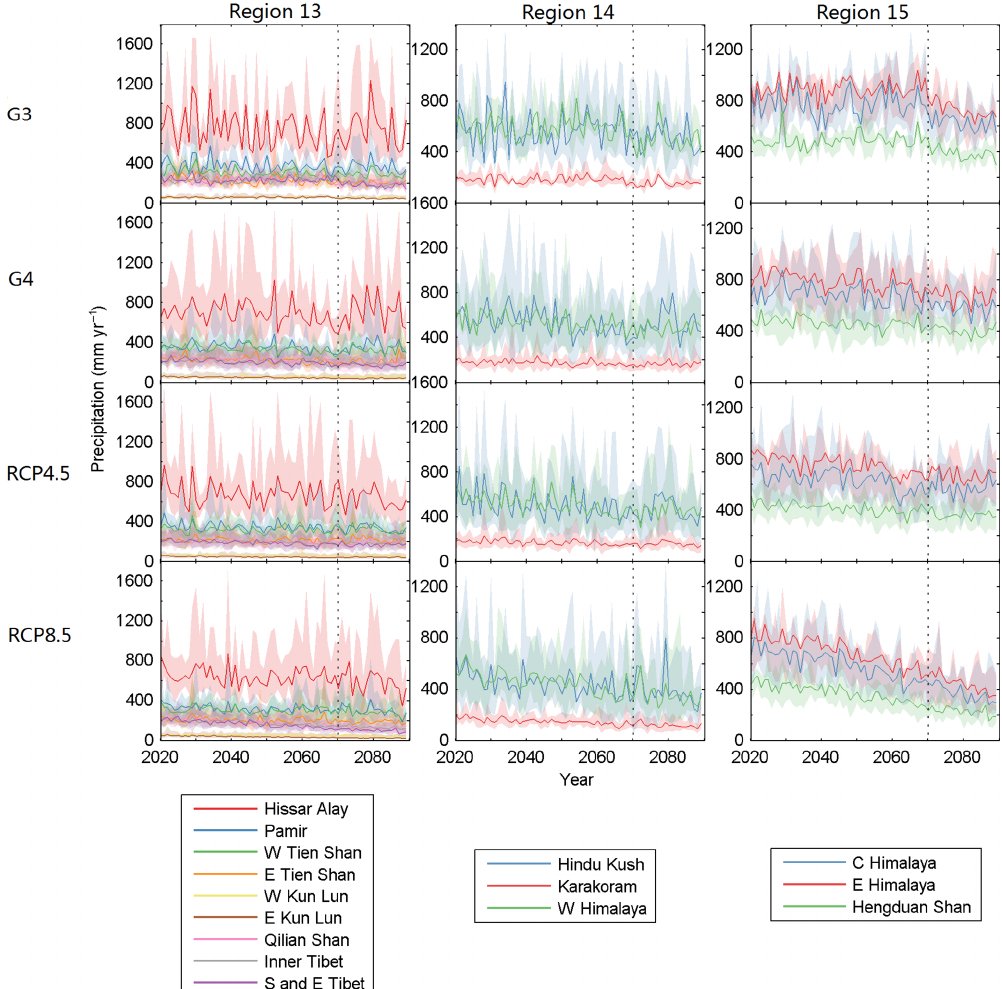
Figure 6. As that for Fig. 5 but for annual solid precipitation on the glacier.